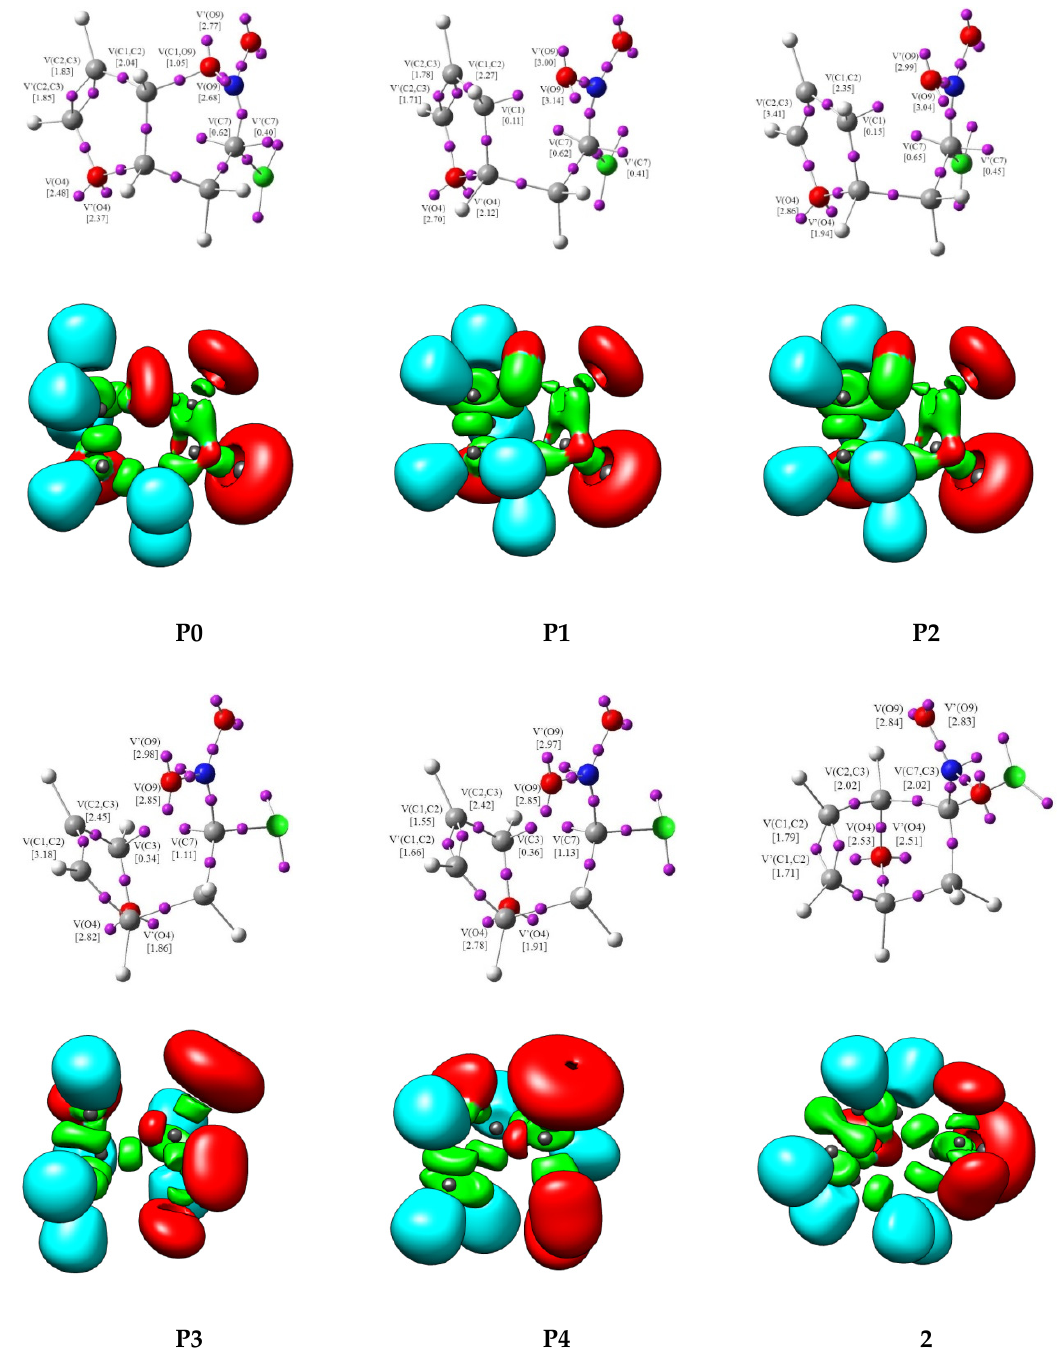
Figure 2. ELF localization domains, represented at isosurface values of ELF = 0.75, together with their attractor positions for the points of IRC defining Phases I–VII along the rearrangement of nitronic ester 1 into nitronorbornene 2 .